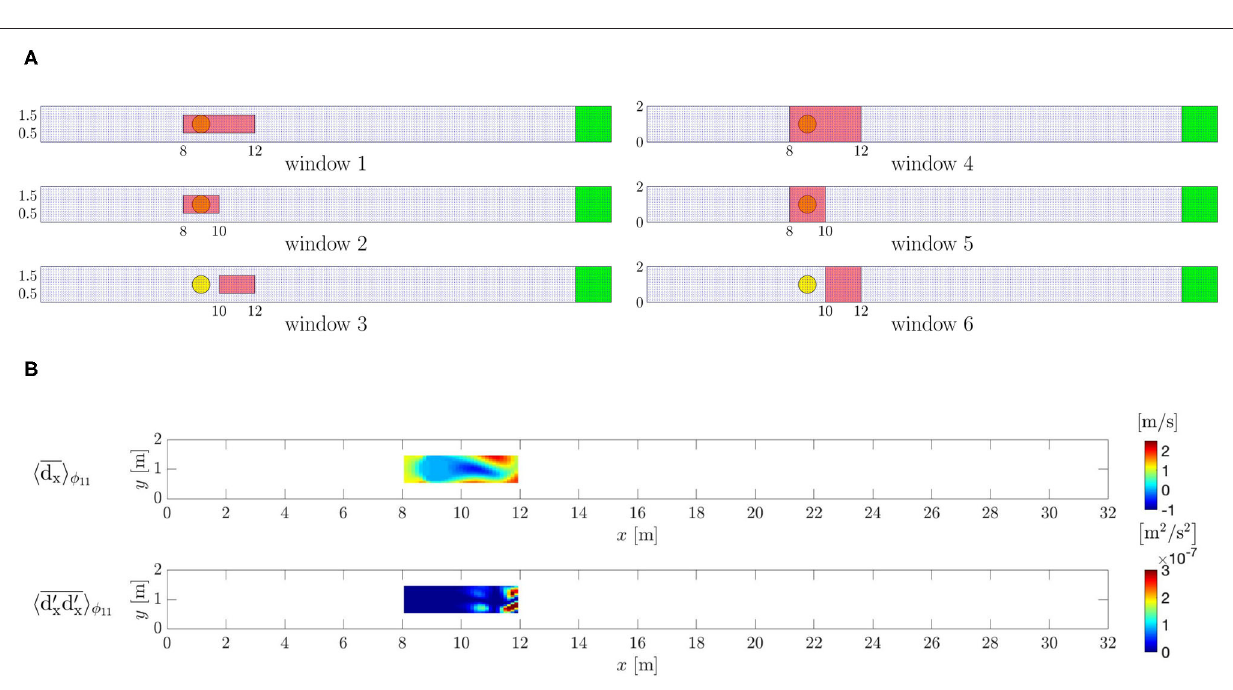
FIGURE 4 | Periodically oscillating flow. (A) Windows where the data are extracted from the ground-truth flow field. (B) Mean x -velocity and associated xx - covariance component observed from the ground-truth DNS within window